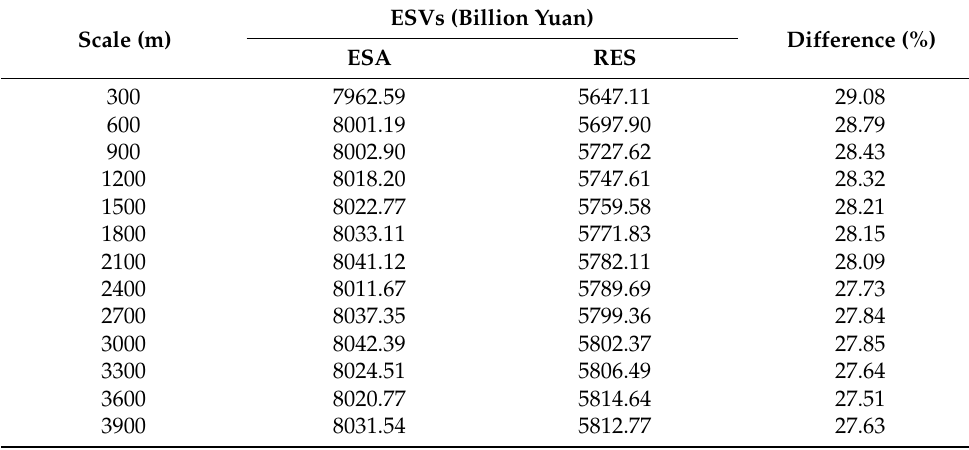
Table 1. Overall ESVs of ESA and RES at different scales and their